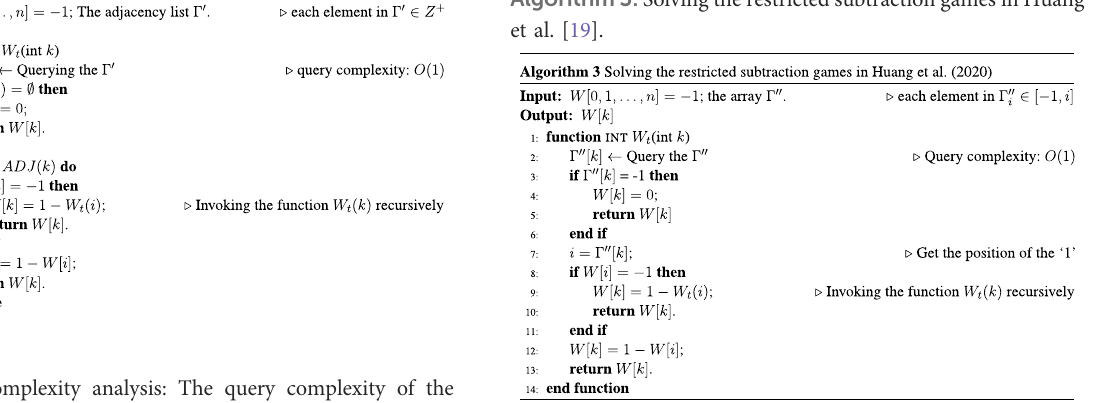
Algorithm 3. Solving the restricted subtraction games in